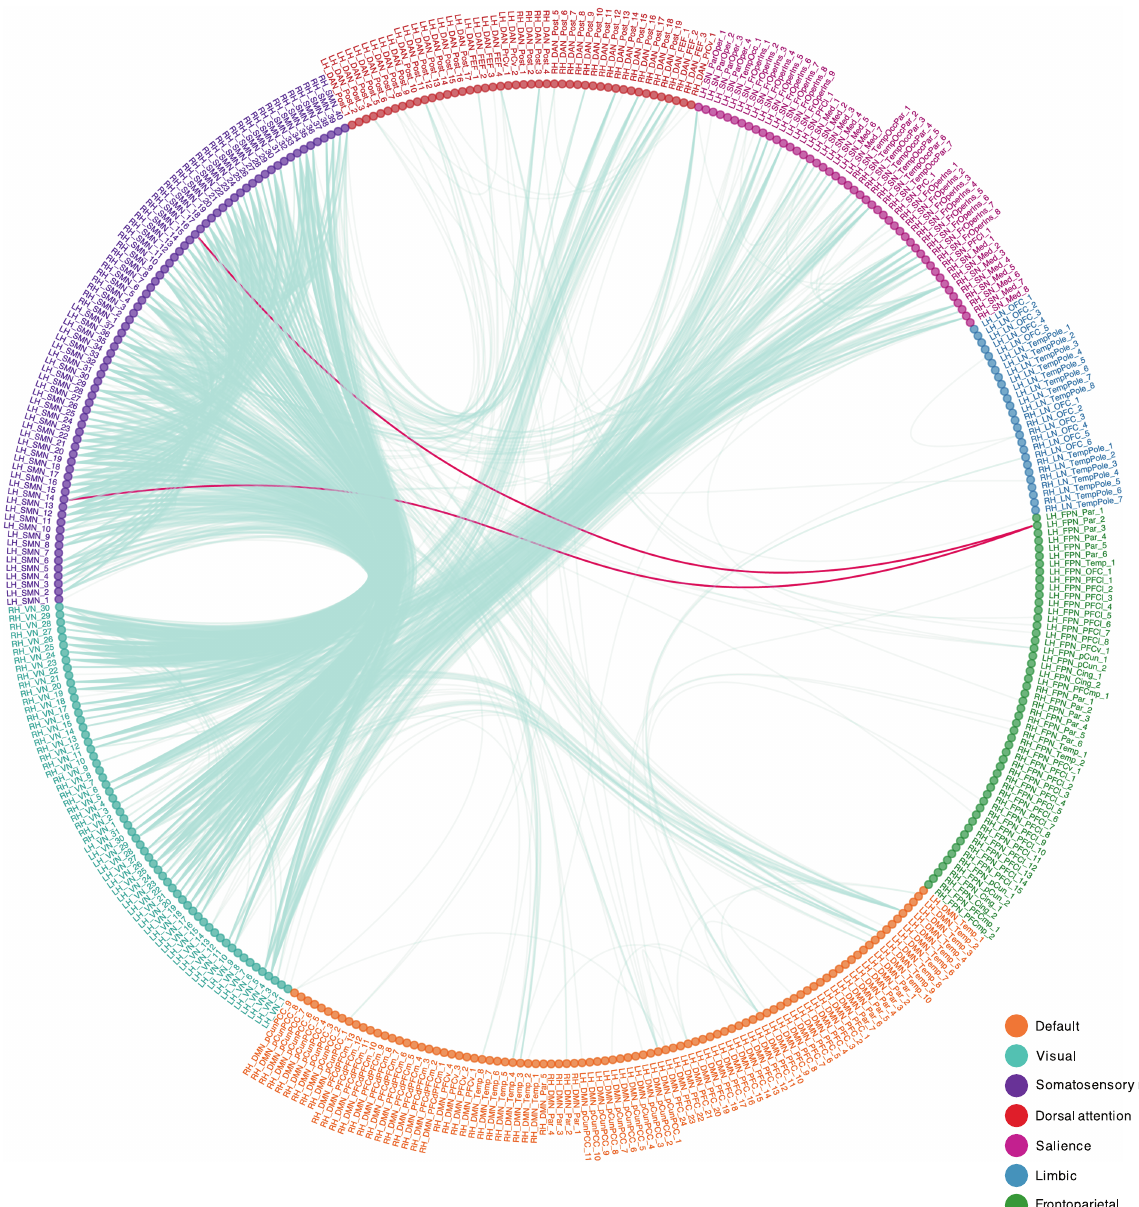
Fig. 1 Group differences in FCs between 400 nodes of the seven cortical networks. In this fi gure each color in the circle represents a network. The blue lines show lower FC in patients with MDD compared to HCs and the red lines show greater FC in patients with MDD compared to HCs. The FC differences between patients with MDD and healthy controls as estimated mean differences regarding 400 nodes (79,800 FC) were obtained from linear mixed effect model (LMER) with age, gender, mean framewise displacement as fi xed variable and site as random variable. The false discovery rate (FDR) was used to correct for multiple comparisons ( p -value <